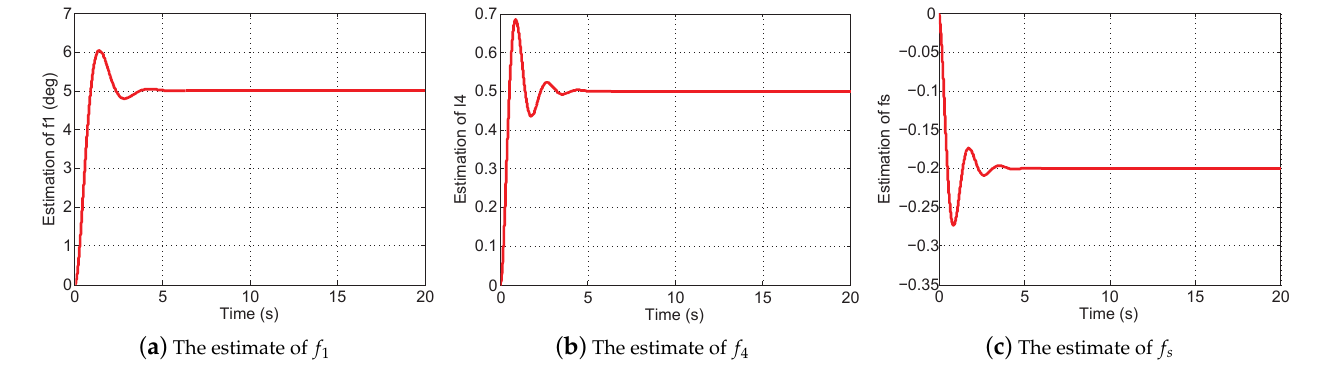
Figure 11. Estimates of fault